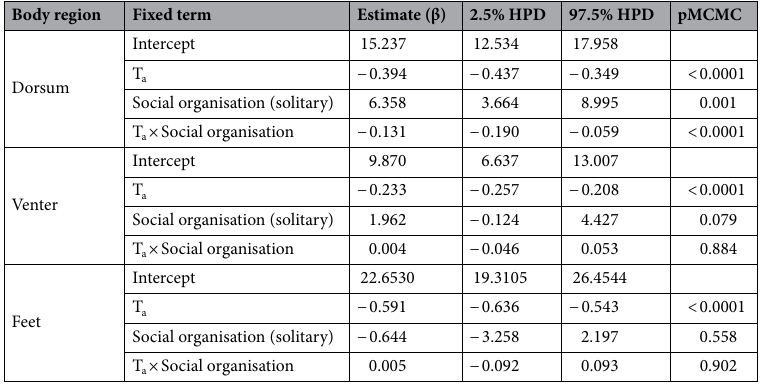
Table 4. Relationships between the difference between core body and surface temperature (T diff ) of the three body regions, ambient temperature (T a ), and social organisation (solitary vs. social) in seven species of subterranean rodents. 2.5% HPD and 97.5% HPD represent lower and upper highest posterior density intervals; pMCMC denotes to the p value obtained from MCMCglmm; T a × Social organisation = interaction between T a and social organisation.